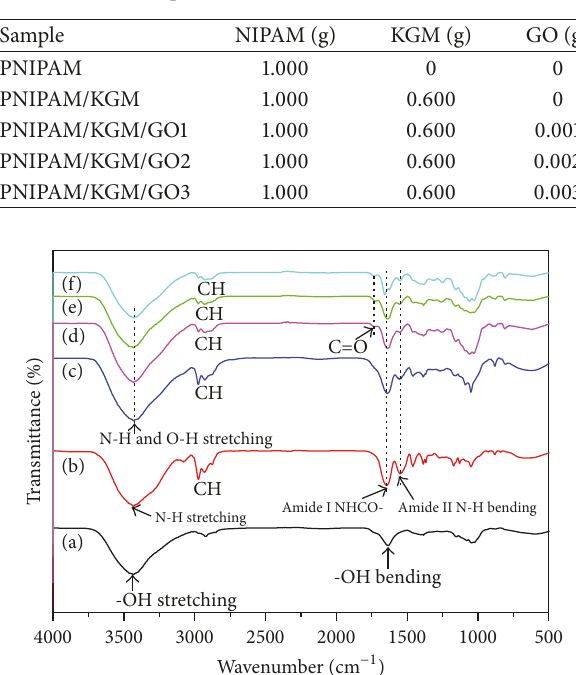
Figure 1: FTIR spectra of KGM (a), PNIPAM (b), PNIPAM/KGM (c), PNIPAM/KGM/GO1 (d), PNIPAM/KGM/GO2 (e), and PNI- PAM/KGM/GO3 (f) composite membranes.